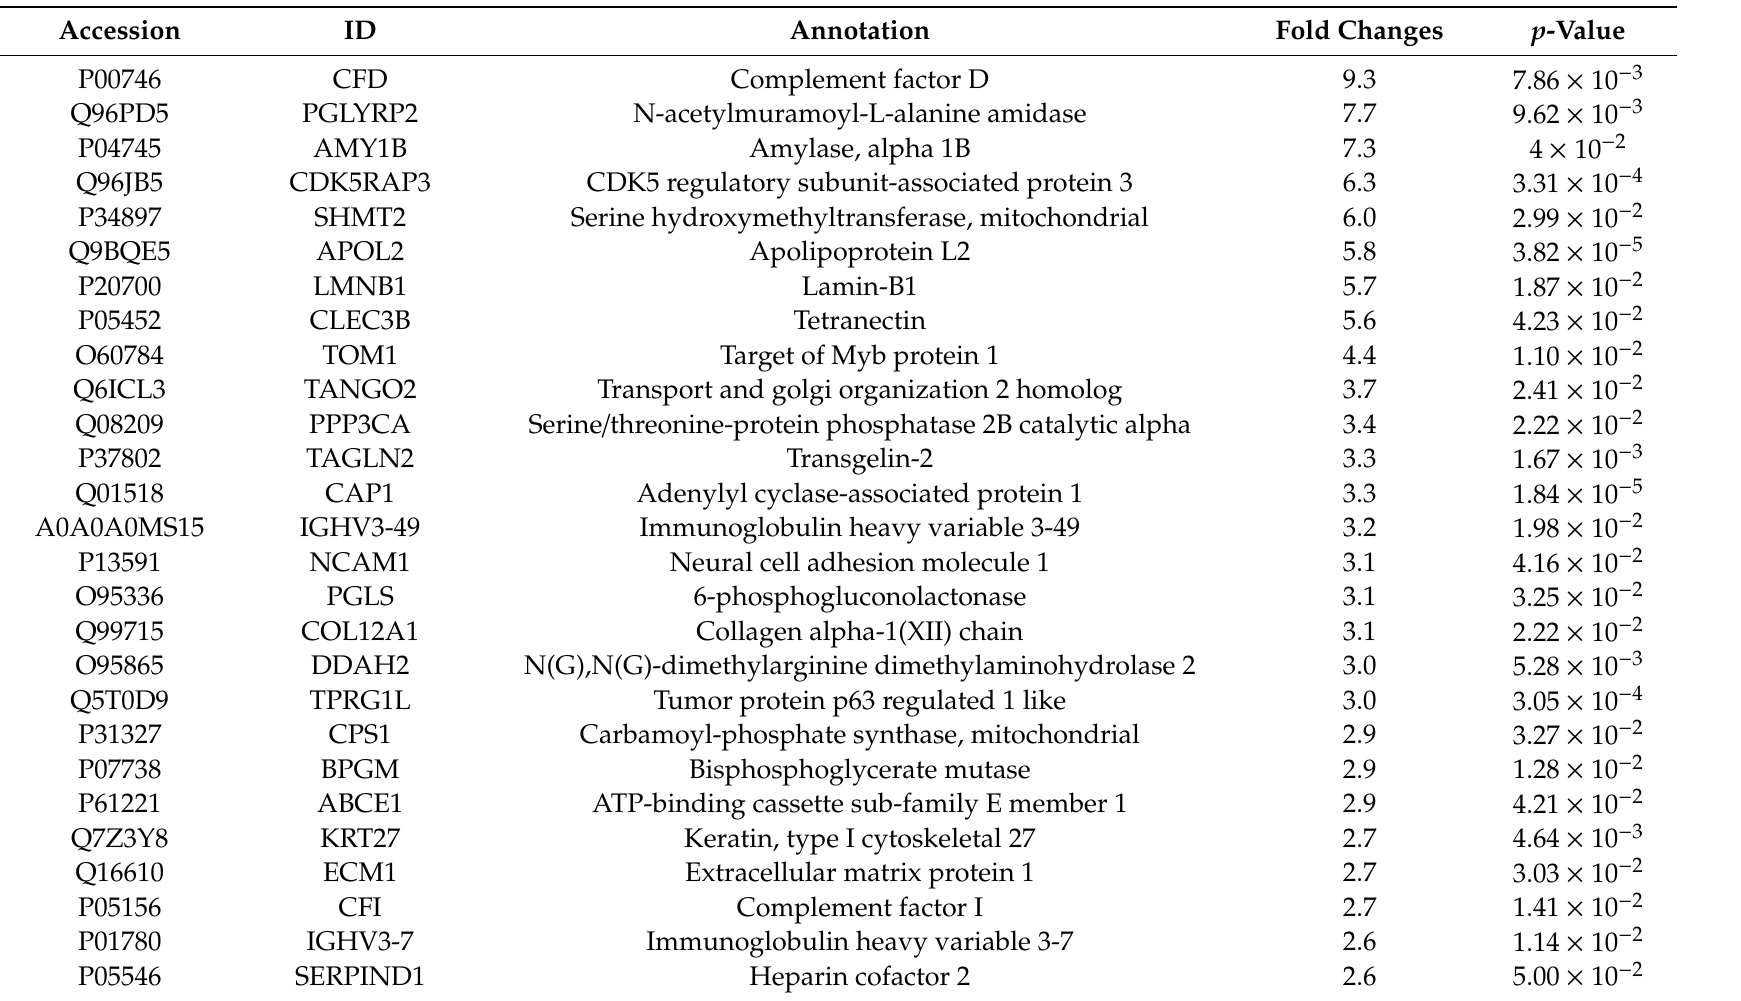
Table 1. Significantly deregulated proteins in irradiated cardiac left ventricle proteome. The proteins listed in the table were identified and quantified by two or more unique peptides; fold changes and p -values are